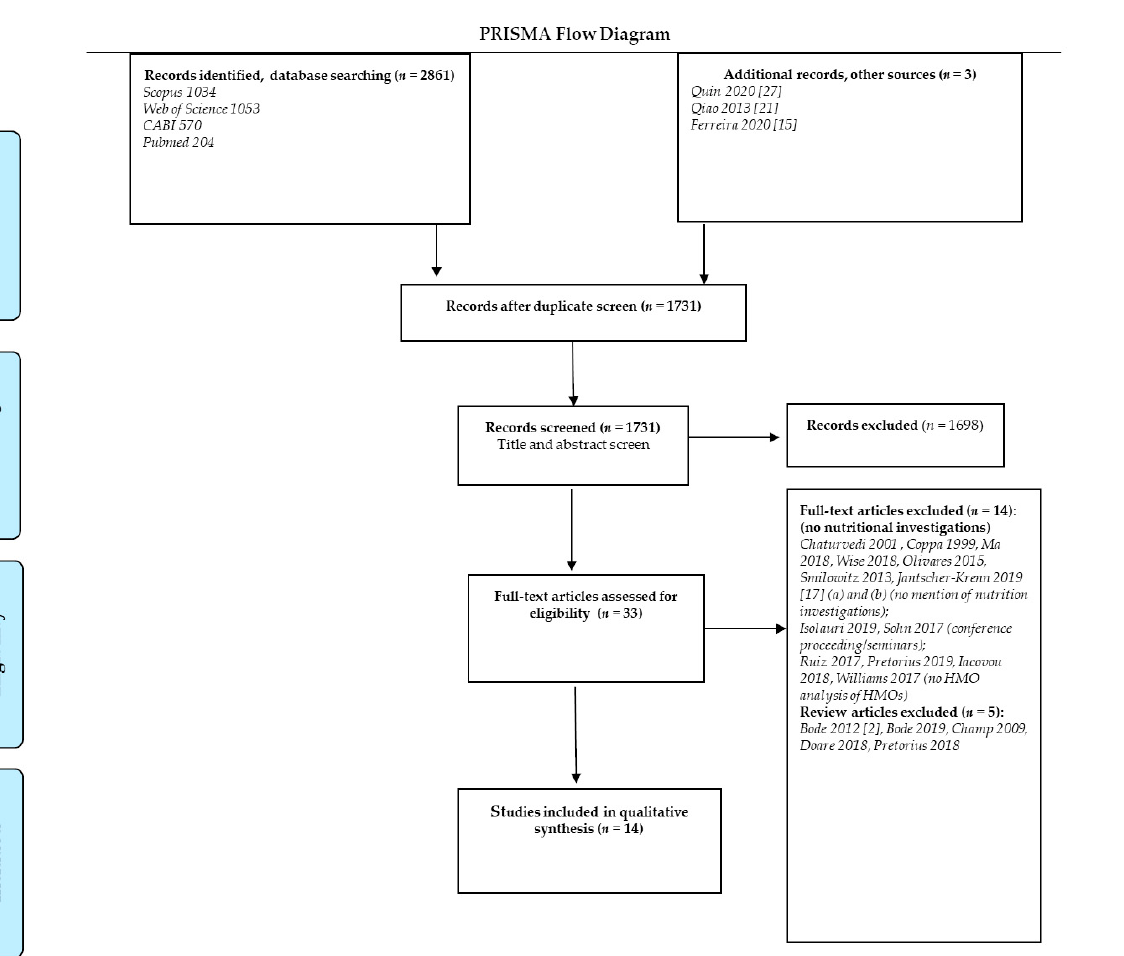
Figure 1. Flow diagram describing study selection process [2,15,17,21,27].